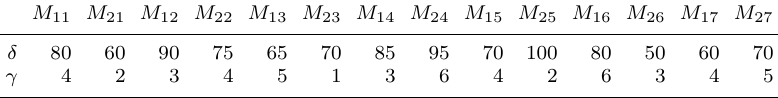
given by Table 7. The regular time cost assigned for senior and junior nurses is